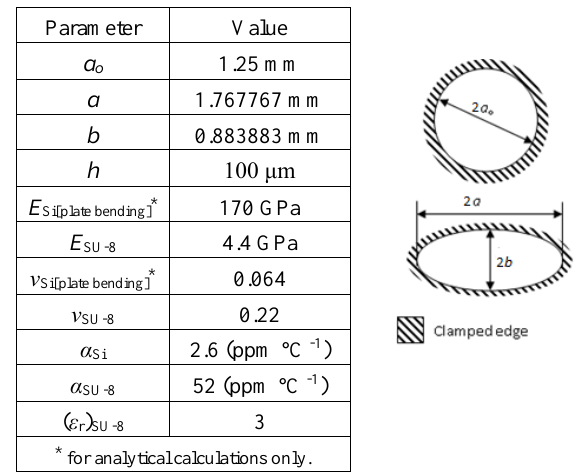
Table 1. Circular and elliptical diaphragms’ design parameters. Table 1 Circular and elliptical diaphragms’ design parameters.